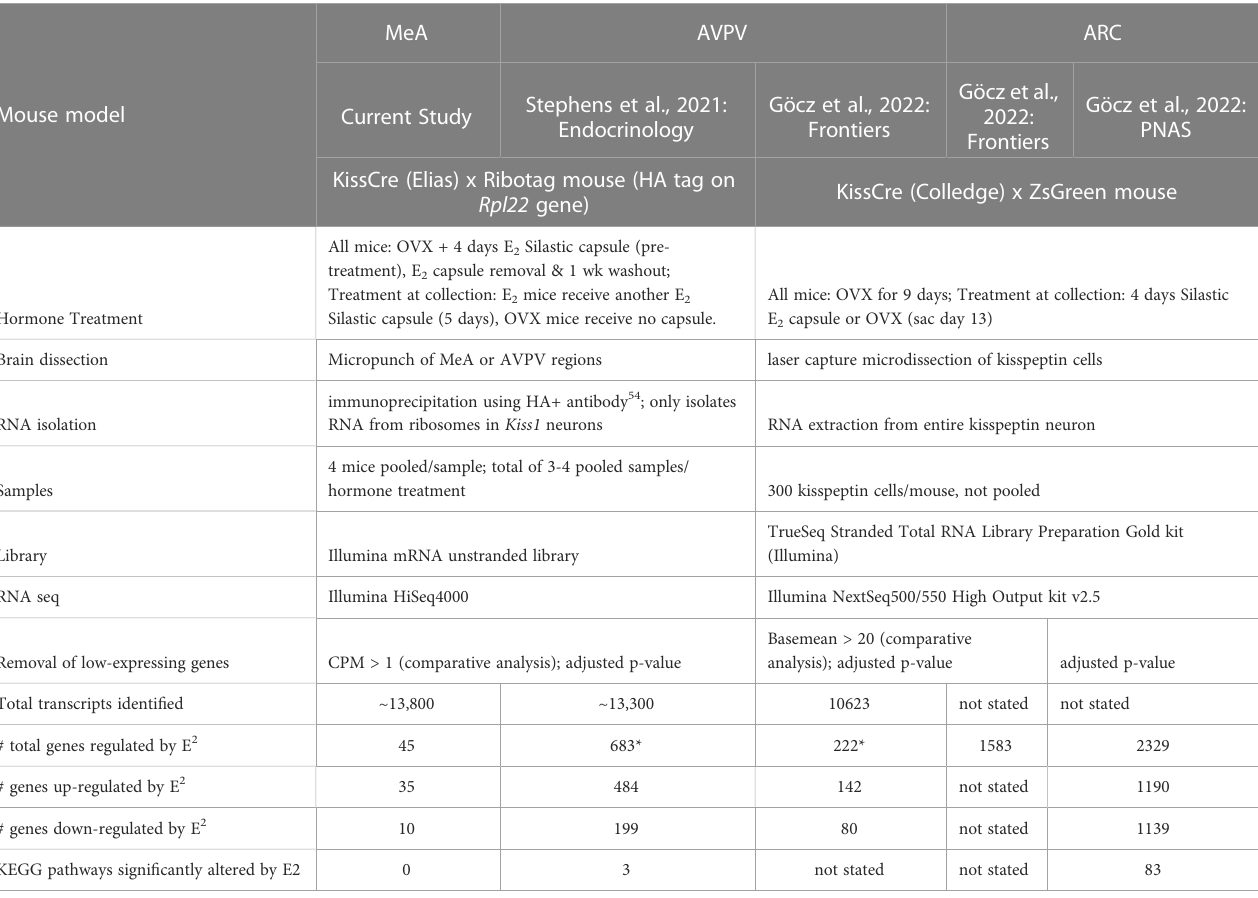
TABLE 6 A comparison of RNA-seq studies from the MeA, AVPV, and ARC kisspeptin neuron populations.